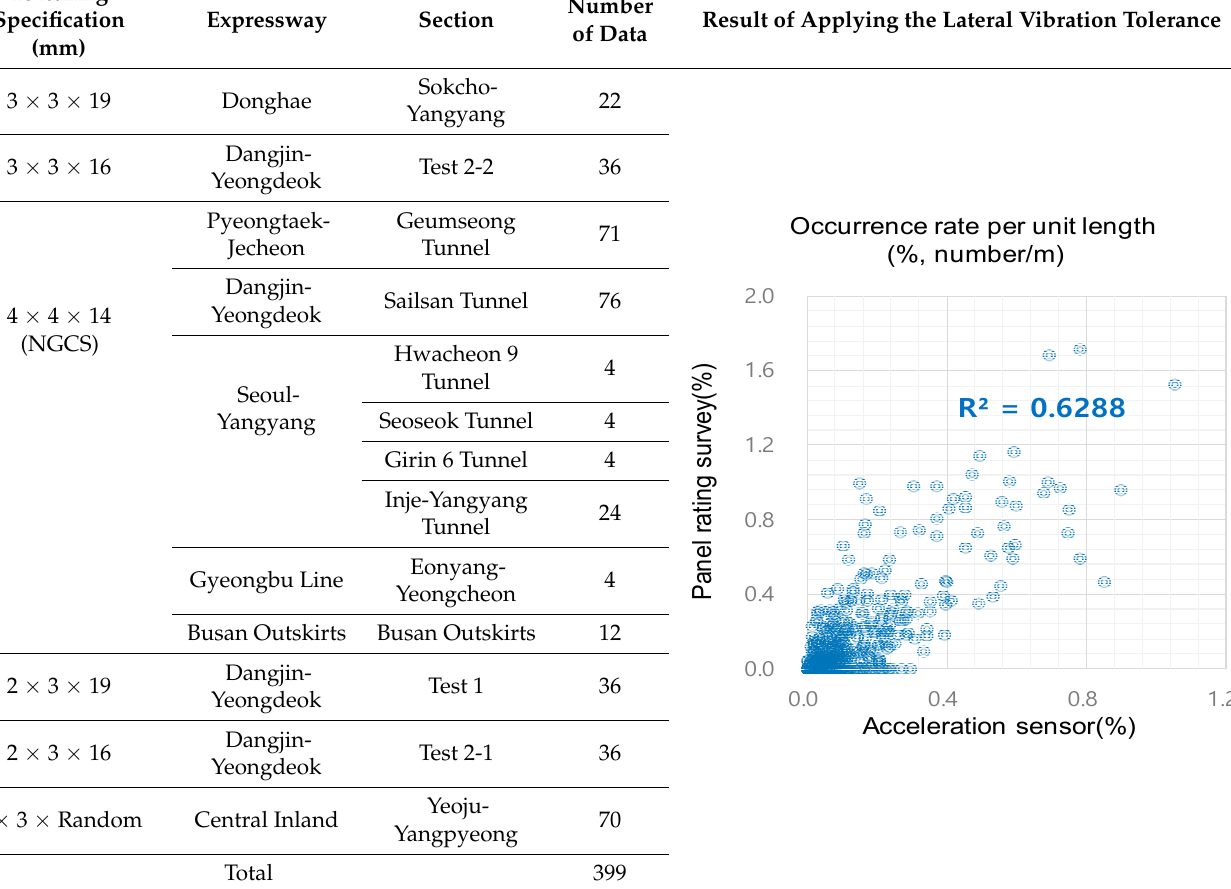
Table 3. Total field investigation sections and data statistics.